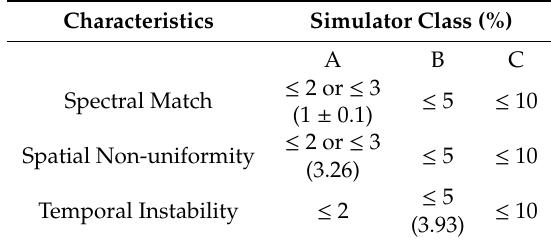
Table 1. Xenon arc lamp solar simulator performance classifications.